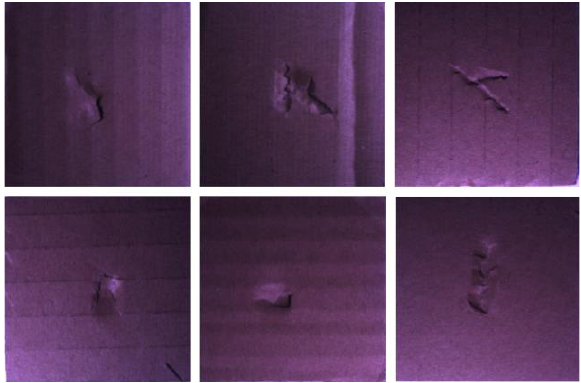
Figure 2. Examples of our real-world dataset.